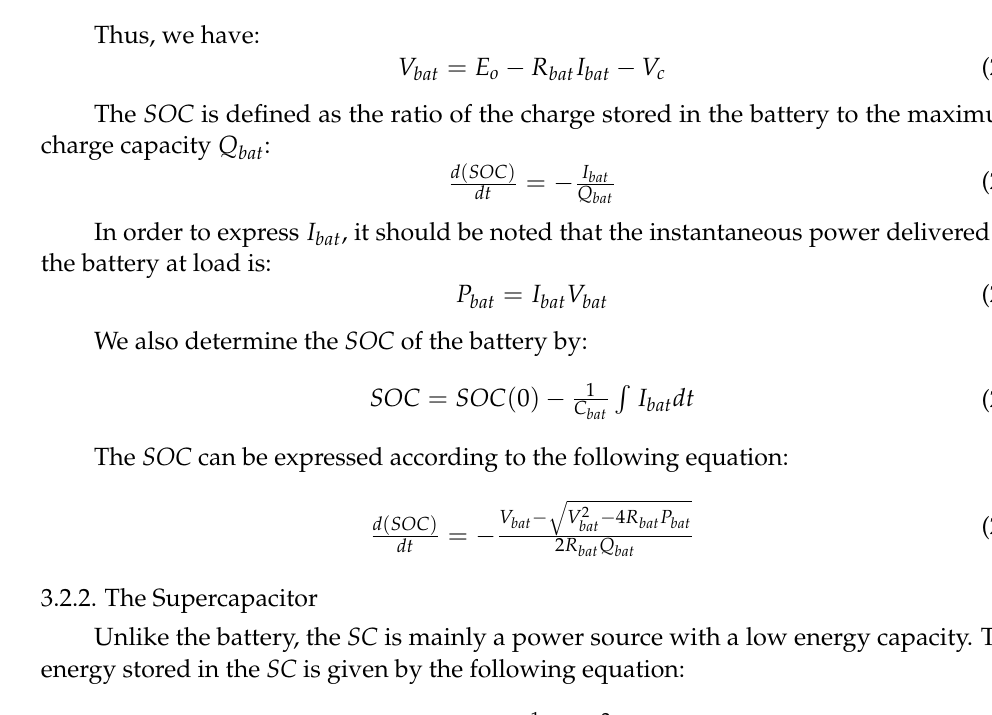
Figure 4. Electrical model of: ( a ) the battery, ( b ) the